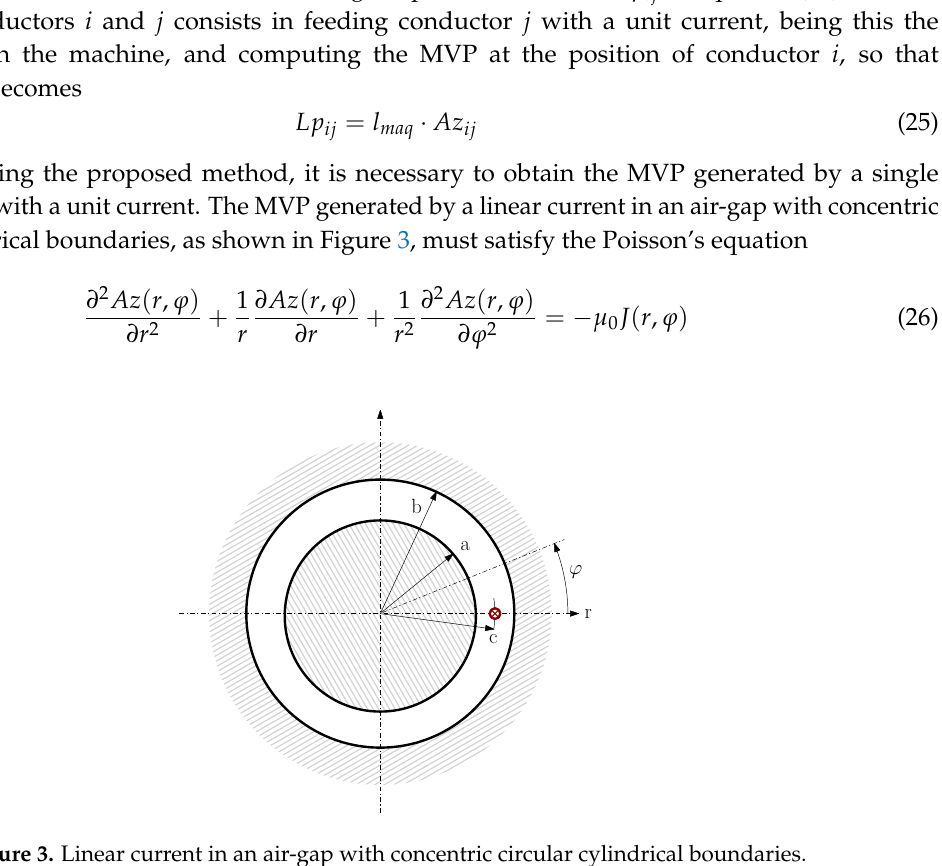
Figure 3. Linear current in an air-gap with concentric circular cylindrical